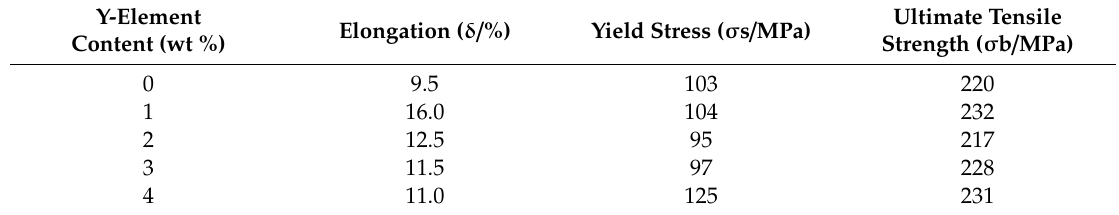
Table 6. Tensile properties of liquid forging parts with different yttrium contents.